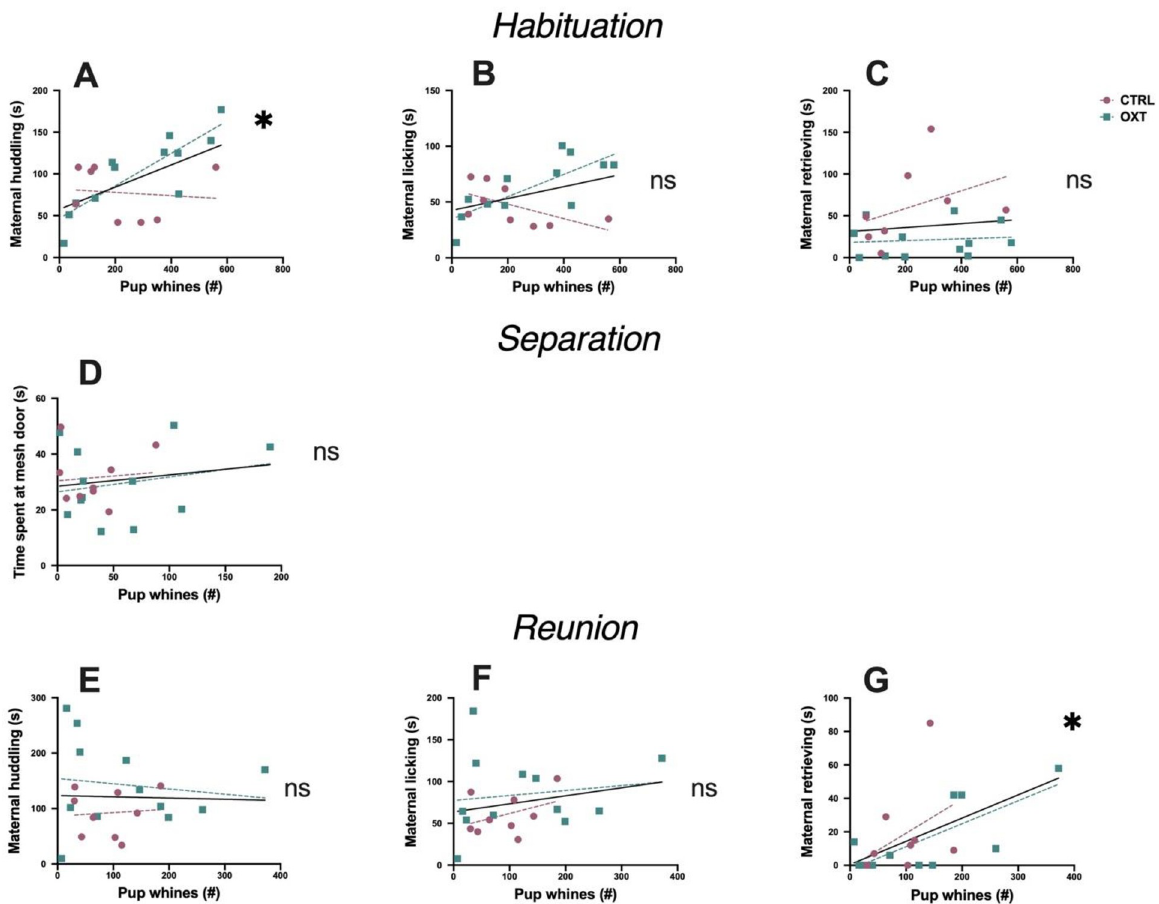
Fig 5. Correlations between pup whine USVs and maternal care. (A-C) Habituation . (A) There was a significant positive correlation between pup whines and maternal huddling. (B) There was no correlation between pup whines and maternal licking or (C) pup whines and maternal retrieval/carrying behavior. (D) Separation . Pup whines did not correlate with time that the mother spent at the mesh gate. (E-G) Reunion . (E) There was no correlation between pup whines and maternal huddling or (F) pup whines and maternal licking. (G) Pup USVs positively correlated with maternal retrieving/carrying. Correlation line in black is the average slope across treatment groups; magenta and teal lines are the slopes for the saline and OXT treatments, respectively. � p <